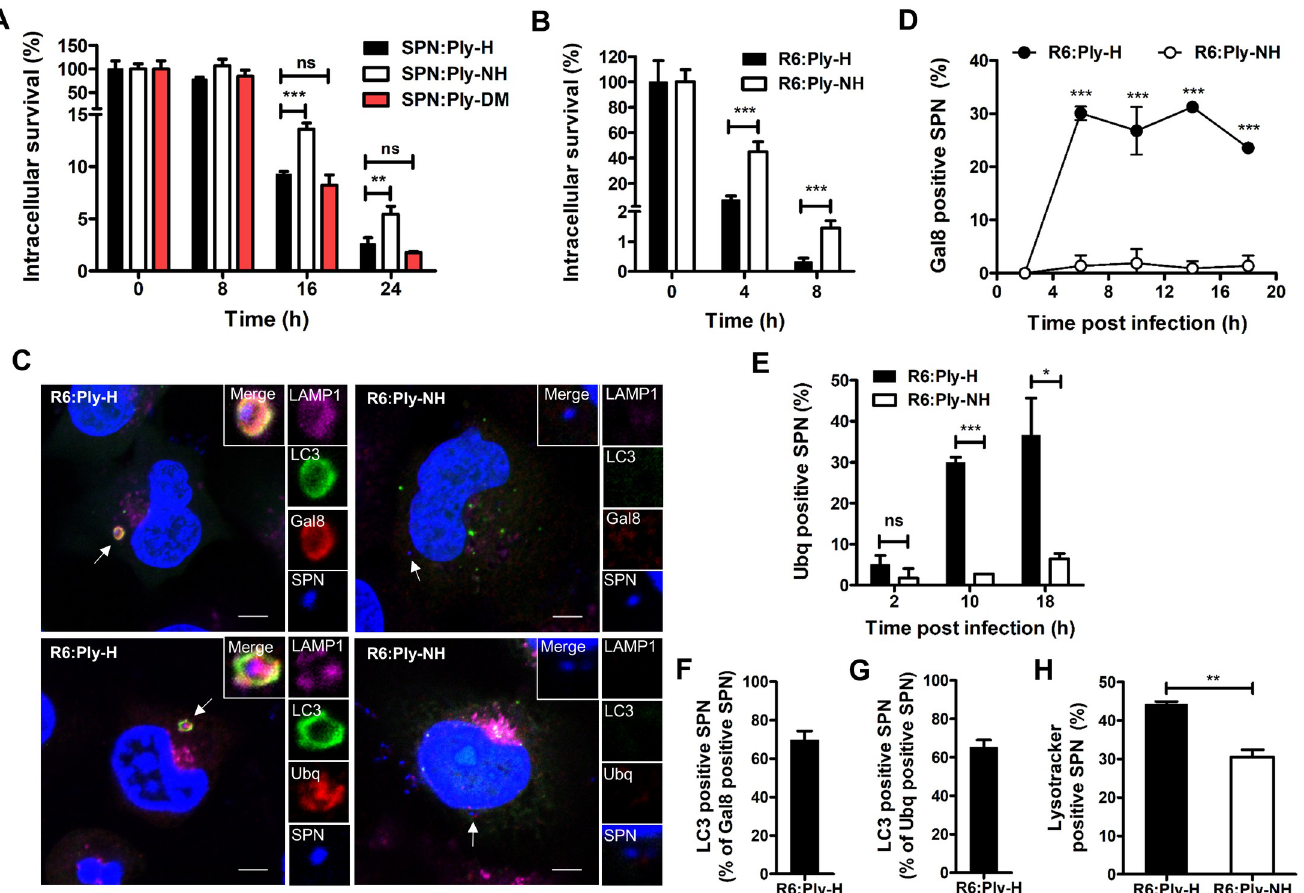
Fig 5. Loss of pore forming ability facilitates prolonged intracellular persistence of SPN. ( A ) Intracellular survival efficiency of SPN R6 strains expressing either Ply-H, Ply-NH or Ply-DM (H150Y+T172I) in A549s were calculated as percentage survival at indicated time points relative to 0 h. ( B ) Intracellular survival efficiency of SPN R6 strains expressing either Ply-H or Ply-NH in THP-1 macrophages. ( C ) Confocal micrographs showing association of SPN (blue) expressing Ply-H or Ply- NH with Gal8 or Ubq (red), LC3 (green) and LAMP1 (pink) in A549s at 10 h.p.i. DAPI (blue) has been used to stain A549 nucleus and SPN DNA. Arrows designate the bacteria shown in insets. Event was localized at z-stack number: 4 out of 7 (for R6:Ply-H_Gal8 image), 4 out of 7 (for R6:Ply-H_Ubq image), 4 out of 8 (for R6:Ply- NH_Gal8 image) and 7 out of 11 (for R6:Ply-NH_Ubq image). Scale bar: 5 μ m. ( D ) Percent co-localization of Gal8 with SPN strains expressing either Ply-H or Ply- NH in A549s at indicated time points post-infection. ( E ) Percentage co-localization of Ubq with SPN strains expressing either Ply-H or Ply-NH in A549s at indicated time points post-infection. ( F-G ) Quantification of co-localization of LC3 with Gal8 (F) or Ubq (G) positive R6:Ply-H in A549s at 10 h.p.i. ( H ) Quantification of co- localization of SPN strains expressing either Ply-H or Ply-NH with Lysotracker in A549s at 18 h.p.i. Data information: Experiments are performed thrice and data of representative experiments are presented as mean ± SD of triplicate wells. n � 100 SPN per coverslip (D-H). Statistical analysis was performed using one-way ANOVA with Tukey’s multiple comparison test (A) and Student’s two-tailed unpaired t-test (B, D-E, H). ns, non-significant; � p < 0.05; �� p < 0.01; ��� p < 0.001.